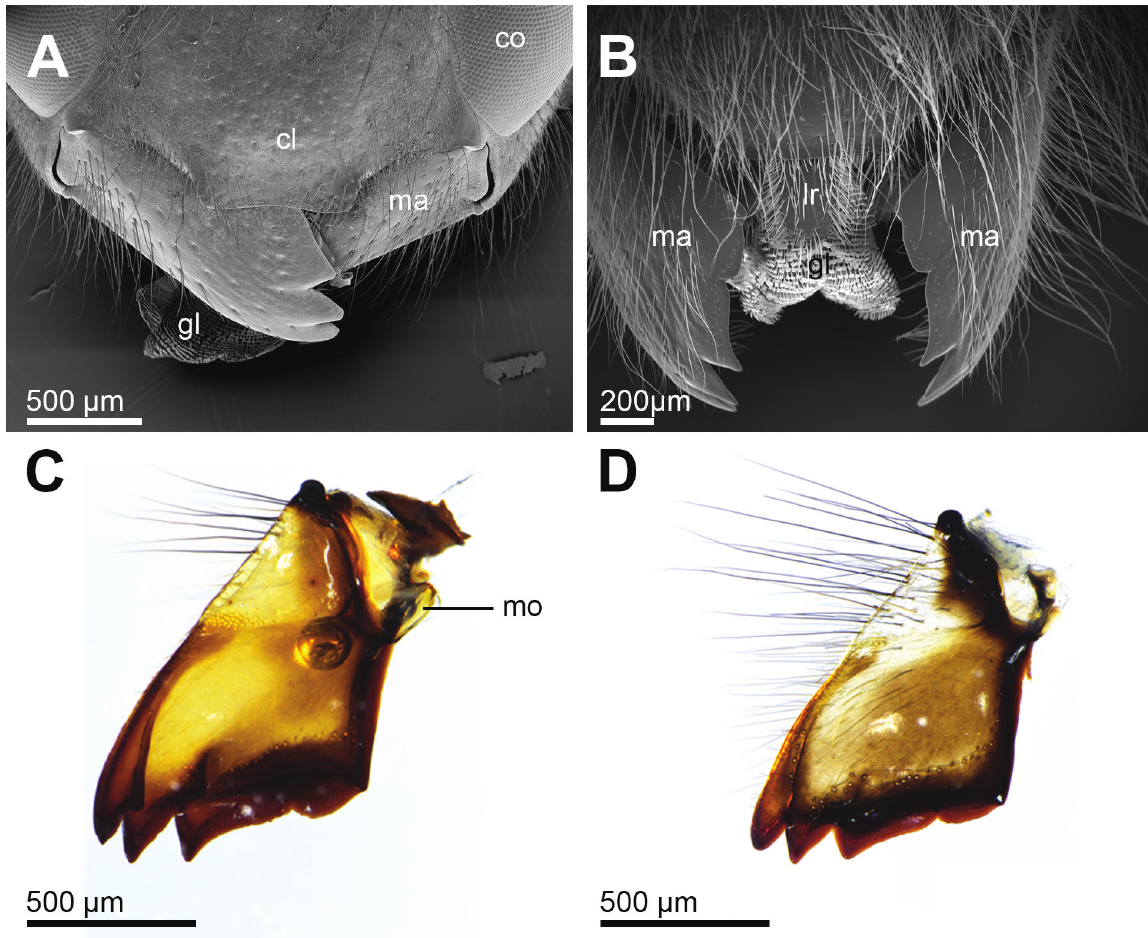
Figure 2. Mandibles and labrum (SEM, LM). A. Mandibles ( ma ) overlapping in repose in front of the clypeus ( cl ); co – compound eye, gl – glossa. B. Open mandibles ( ma ), labrum ( lr ) and glossa ( gl ) underneath (male wasp). C. Mandible of female (LM), short bristles and mola ( mo ). D. Mandible of male (LM), long bristles and inconspicuous inner